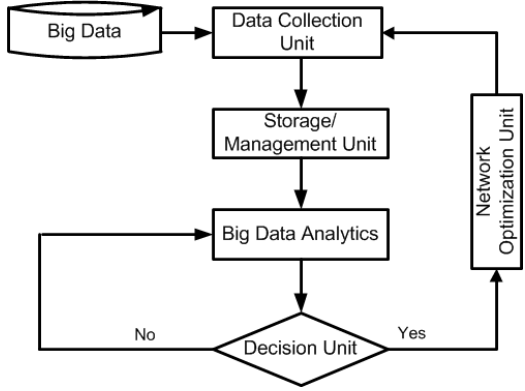
Figure 5. Big data flow